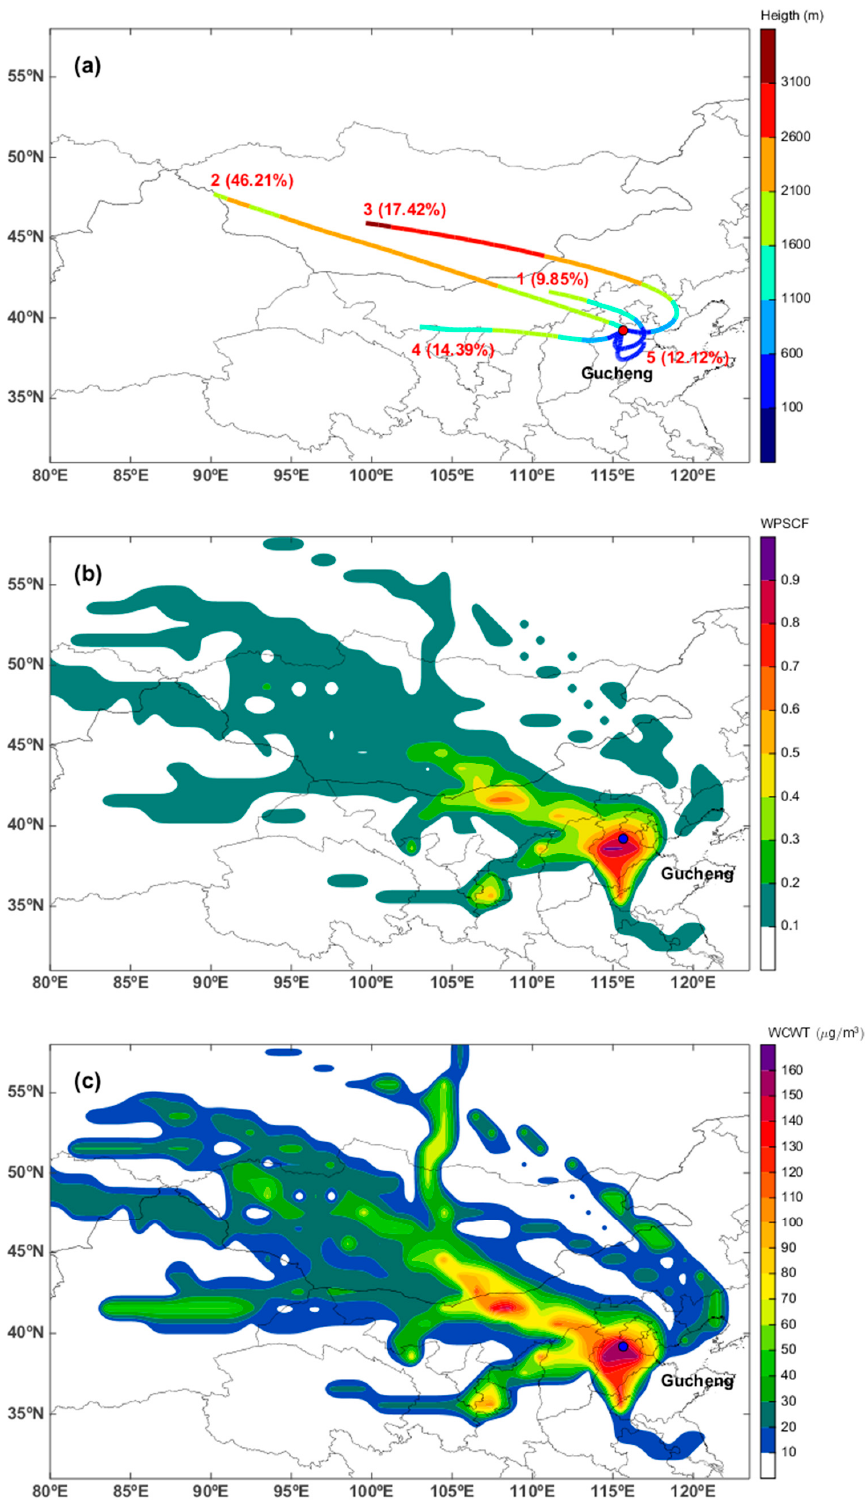
Figure 7. ( a ) Air mass back trajectory clusters, ( b ) weighted potential source contribution function (WPSCF) map, and ( c ) weighted concentration weighted trajectory (WCWT) map for PM 2.5 during the sampling period.